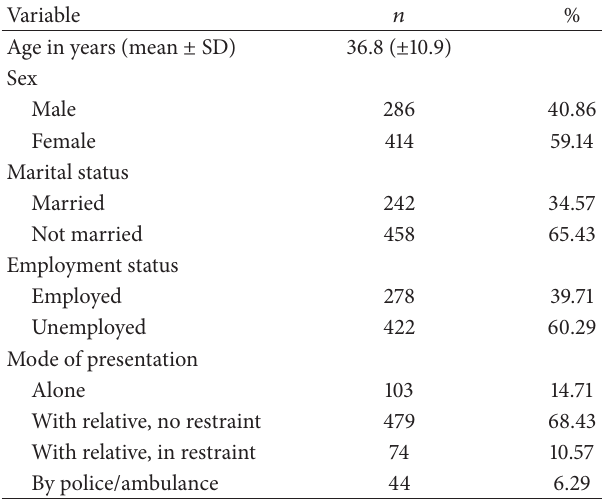
Table 1: Sociodemographic characteristics of the participants ( 𝑁 = 700 ).